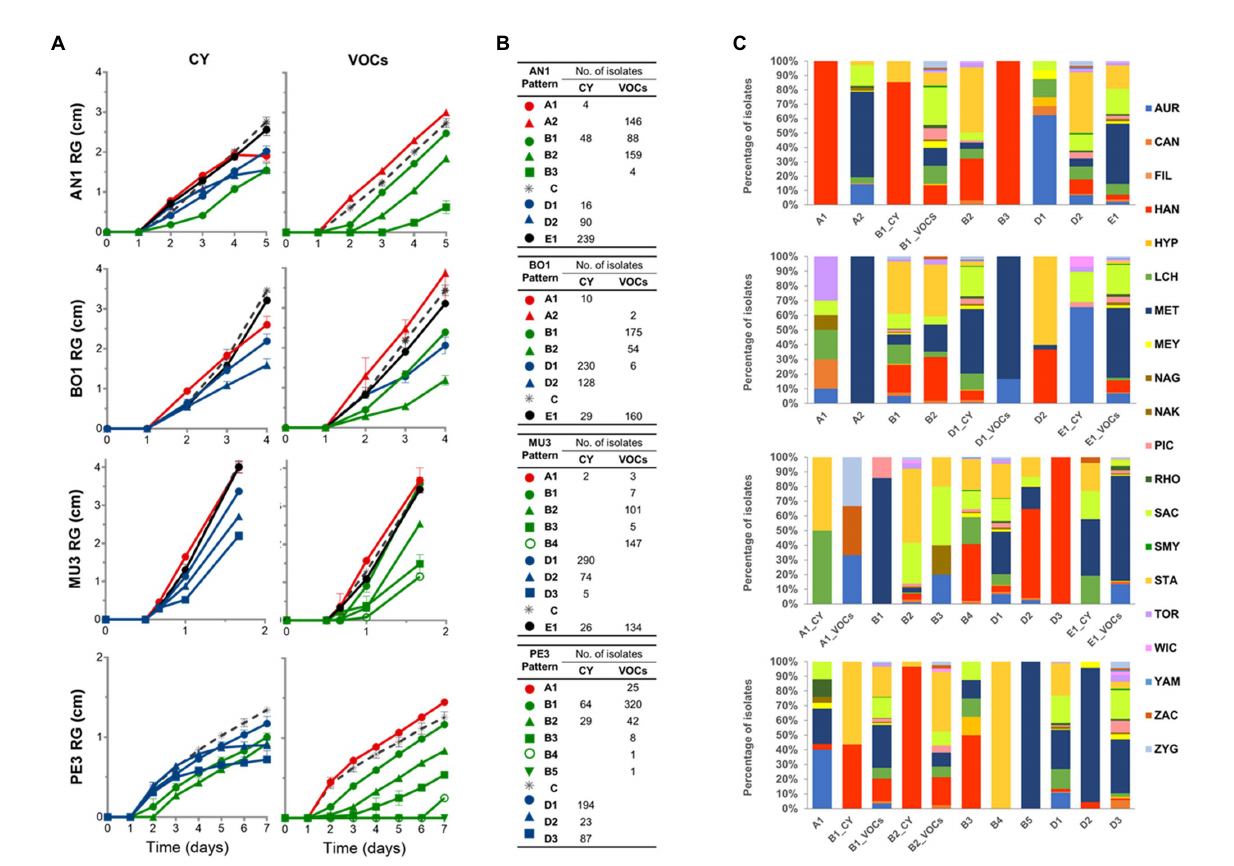
FIGURE 4 Representative growth patterns of the mold targets in response to yeast activity mediated by diffusible (CY) and volatile compounds (VOCs). Representative growth patterns of Aspergillus niger AN1 , Botrytis cinerea BO1, Mucor sp. MU3 and Penicillium sp. PE3 in response to yeast activity were defined based on hierarchical clustering with Pearson correlation coefficient and UPGMA of time-course measurements (A) . Different colors were assigned to highlight the different mold growth patterns induced by yeasts: stimulatory effect (patterns A, in red); inhibition or delaying of the germination of mold spores (patterns B, in green); delayed effect on the growth rate (patterns D, in blue); no effect (pattern E, in black). For each target, mold growth pattern in the absence of yeast (control) is represented by the gray dashed line. The symbols represent mean values, with the bars indicating the standard error. The total number of isolates (B) and the prevalence of the yeast species (C) allocated to each profile are